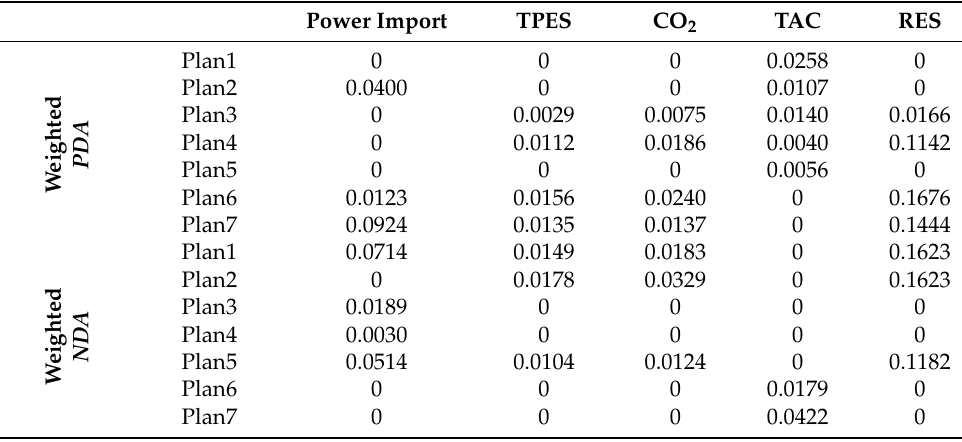
Table 8. Weighted PDA and NDA for seven energy